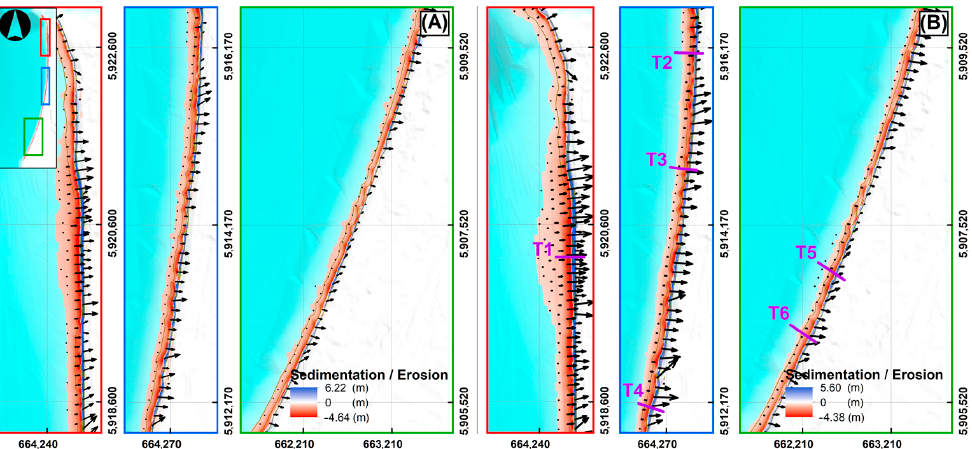
Figure 12. Morphological changes in Escuadrón during: ( A ) winter and ( B ) summer. Blue and red areas indicate accretion and erosion, respectively. Vectors show the average direction of sediment transport, and the gray lines represent the contours. Escuadrón beach is divided into three zones: north (red box), center (blue box), and south (green box). T1-T6 are control transects at Escuadrón beach.